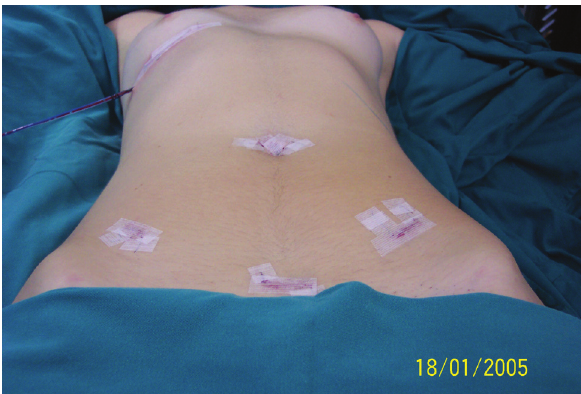
Figure 2 - Four ports are usually used to harvest the omentum